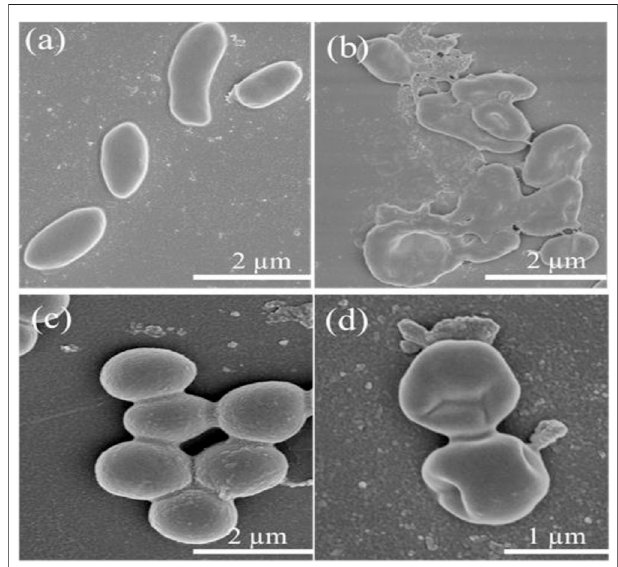
FIGURE 9 | FESEM images of (A – B) E. coli and (C – D) S. aureus treated with different time: (A,C) 0 h and (B,D) 24 h.